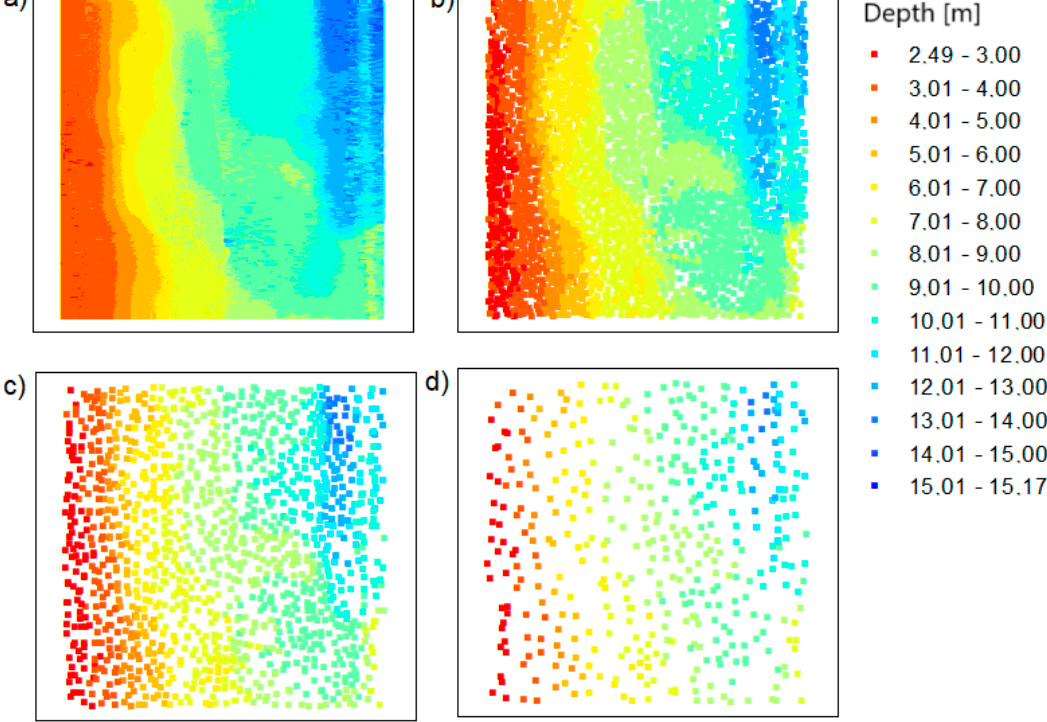
Figure 4. The points based on the LNG port area: ( a ) raw data; ( b ) dataset reduced with the true